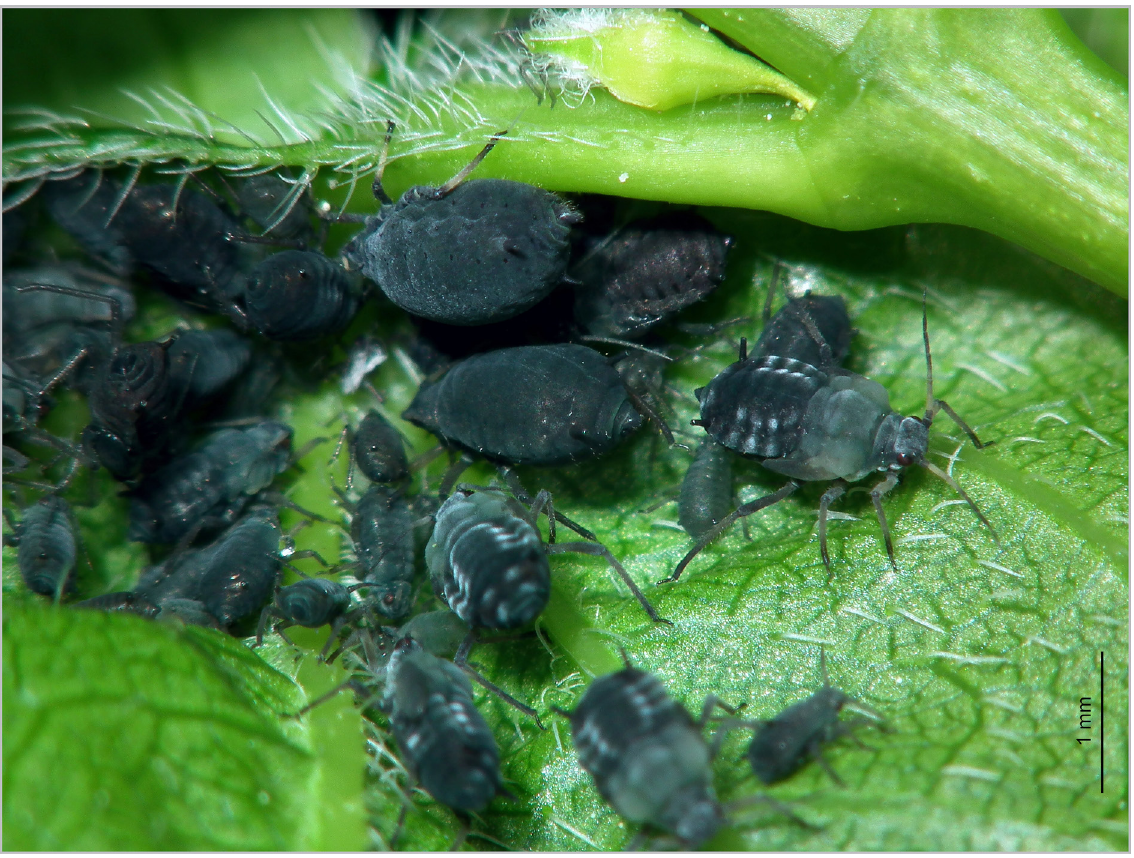
Fig. 26. Aphis (Aphis) fabae Scopoli, 1763. Colony on Philadelphus coronarius L.